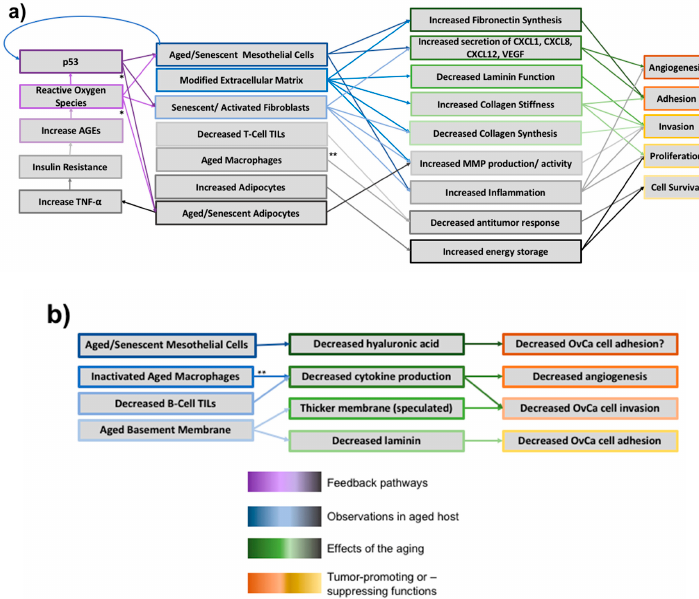
Figure 4. The effects of aging on the peritoneal microenvironment. ( a ) Tumor-Inducing Effects: Aging of the host stimulates a vast and interconnected network of alterations to the peritoneal microenvironment. These changes are often correlated with increased tumor burden due to heightened angiogenesis of the region and OvCa cell adhesion, invasion, proliferation and survival. As depicted, the multifactorial causes and results of aging present significant challenges for analysis; ( b ) Tumor-Suppressing Effects: While our review generally concludes that aging alters the microenvironment in a way conducive to tumor growth, in contrast certain aspects of aging seem to impair tumorigenesis. Aged and senescent mesothelial cells secrete less hyaluronic acid, which is hypothesized to decrease OvCa adhesion to the extracellular matrix (ECM). Inactivated aged macrophages are less capable of cytokine secretion, which thereby decreases angiogenesis potential and cell invasion. The aged BM thickens due to less collagen IV turnover, which we speculate could in theory decrease OvCa invasion (however, to our knowledge no conclusions have been drawn regarding this). The aged basement membrane (BM) also has a decreased laminin content, which may decrease cell adhesion. * While not shown to be a causative link, in aged adipose tissue there is an increase in reactive oxygen species (ROS) that is correlated with adipocytes presenting a senescent phenotype, suggesting that ROS plays the same role in adipocytes that it does in other cell types [145]. p53 has been shown to have numerous effects on adipose tissue and is likely also contributing to the senescent phenotype [145]. ** Aged macrophages paradigm: aged macrophages have been shown to both induce tumorigenesis and inhibit it., we depict both pathways. Note: Color gradients intended to help viewer differentiate between different effects of each component of the aging